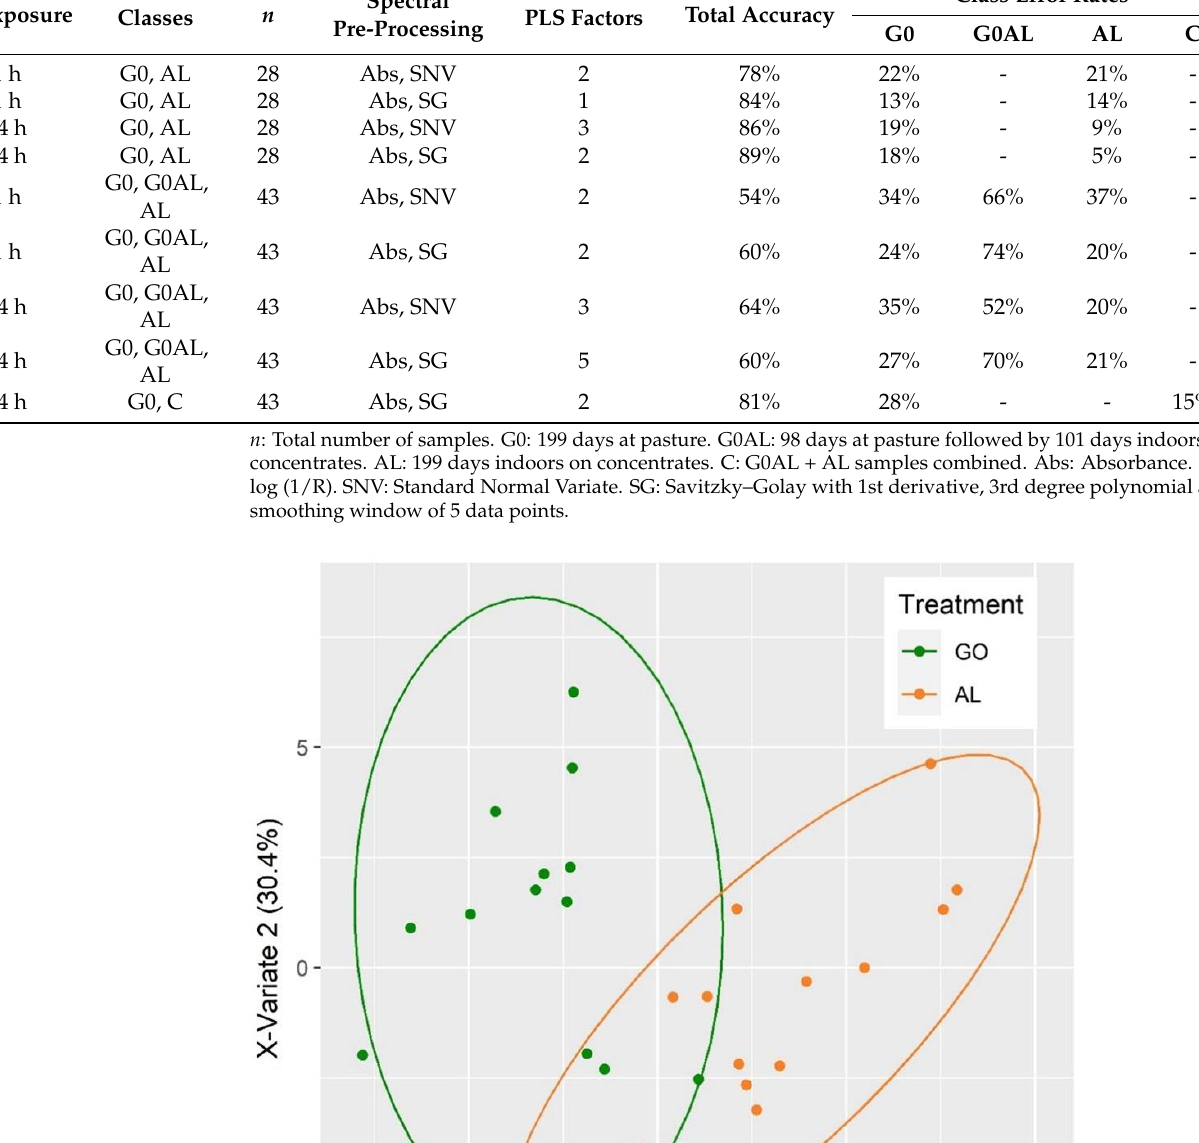
Table 8. Performances in 5-fold cross-validation with 50 repeats of the PLS-DA models developed to discriminate beef according to animal production system using visible reflectance spectral data after 1- or 24-h aerobic exposure.